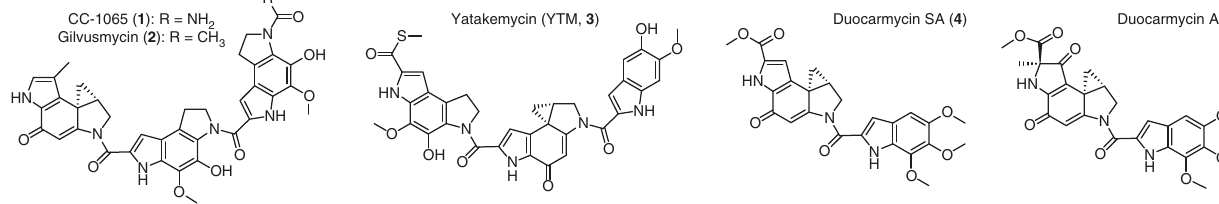
Fig. 1 Chemical structures of the spirocyclopropylcyclohexadienone family of natural products. This family of natural products includes CC-1065 ( 1 ), gilvusmycin ( 2 ), yatakemycin (YTM, 3 ), duocarmycin SA ( 4 ), and duocarmycin A ( 5